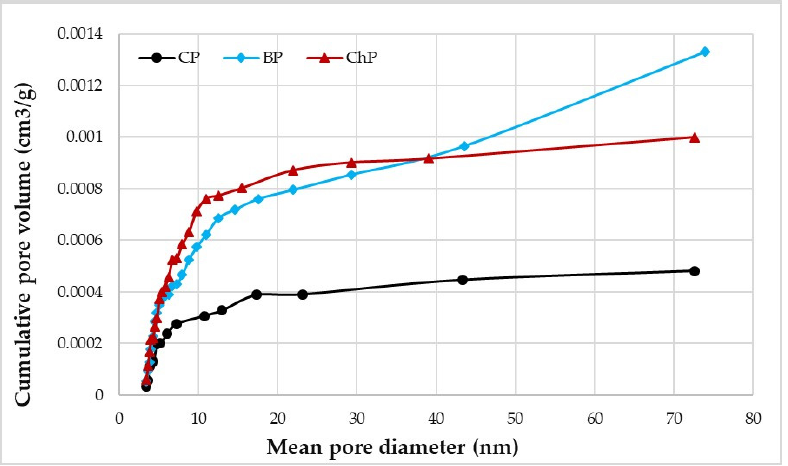
Figure 7. Cumulative pore volume as a function of the pore radius illustrating the different distri- bution types for undegraded and artificially degraded pine wood; CP—contemporary sound pine, BP—biologically degraded pine, ChP—chemically degraded